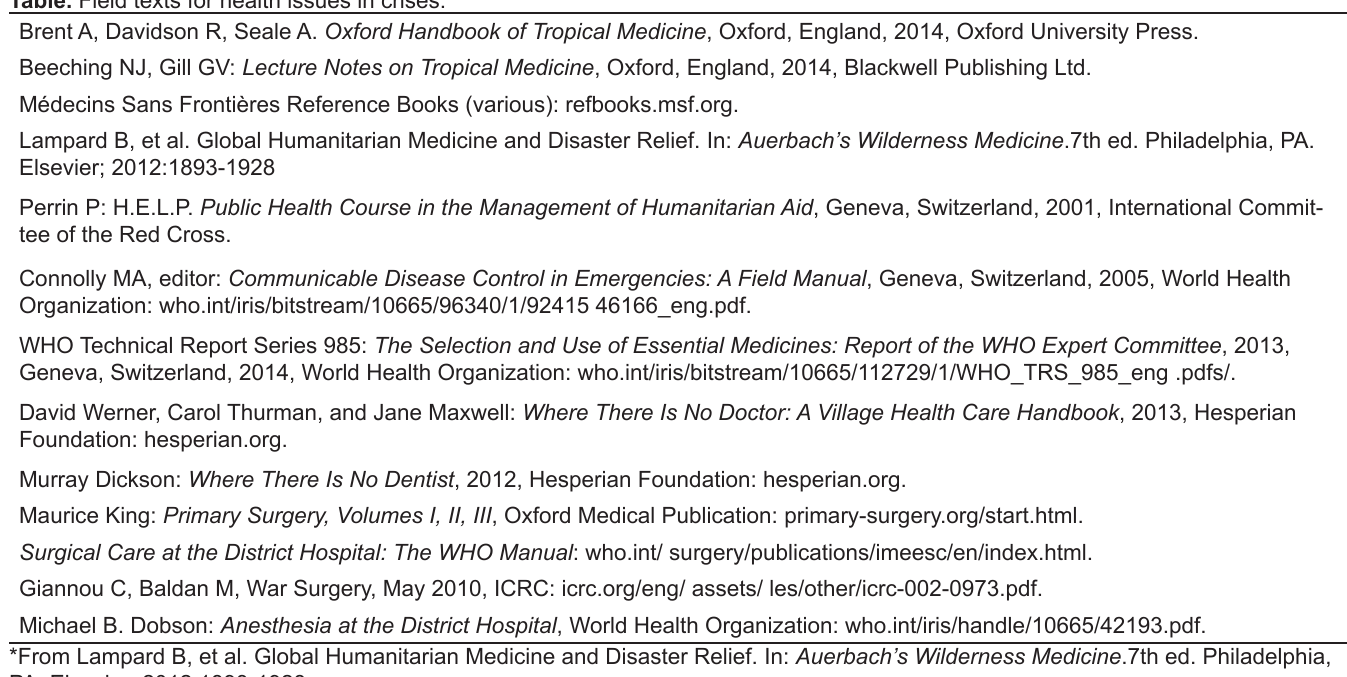
Table. Field texts for health issues in